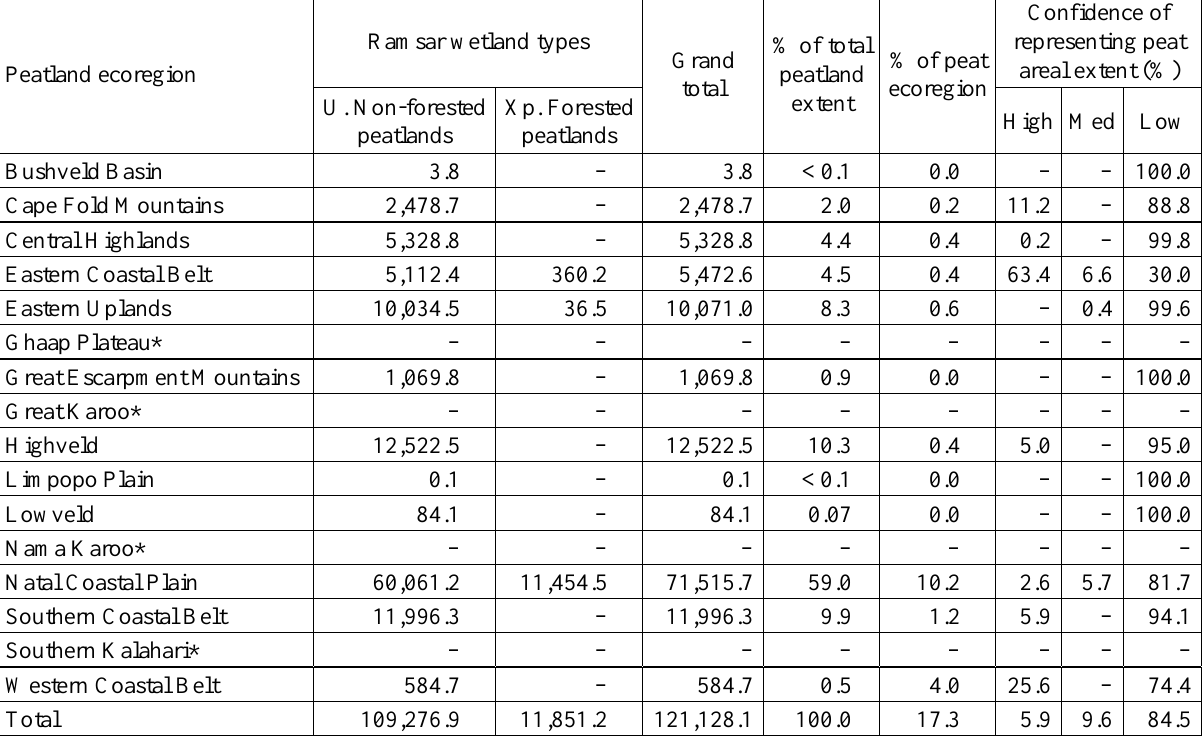
Table 2. Distribution of the geographical extent of peatlands across 16 peat ecoregions (see Figure 1). Asterisks (*) indicate peat ecoregions within which no peat polygons were mapped. Units: ha.